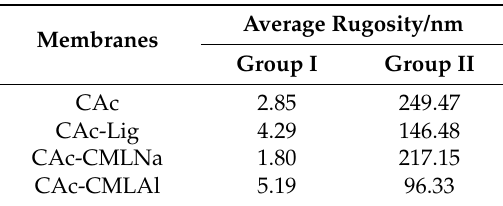
Table 1. Average rugosity of the